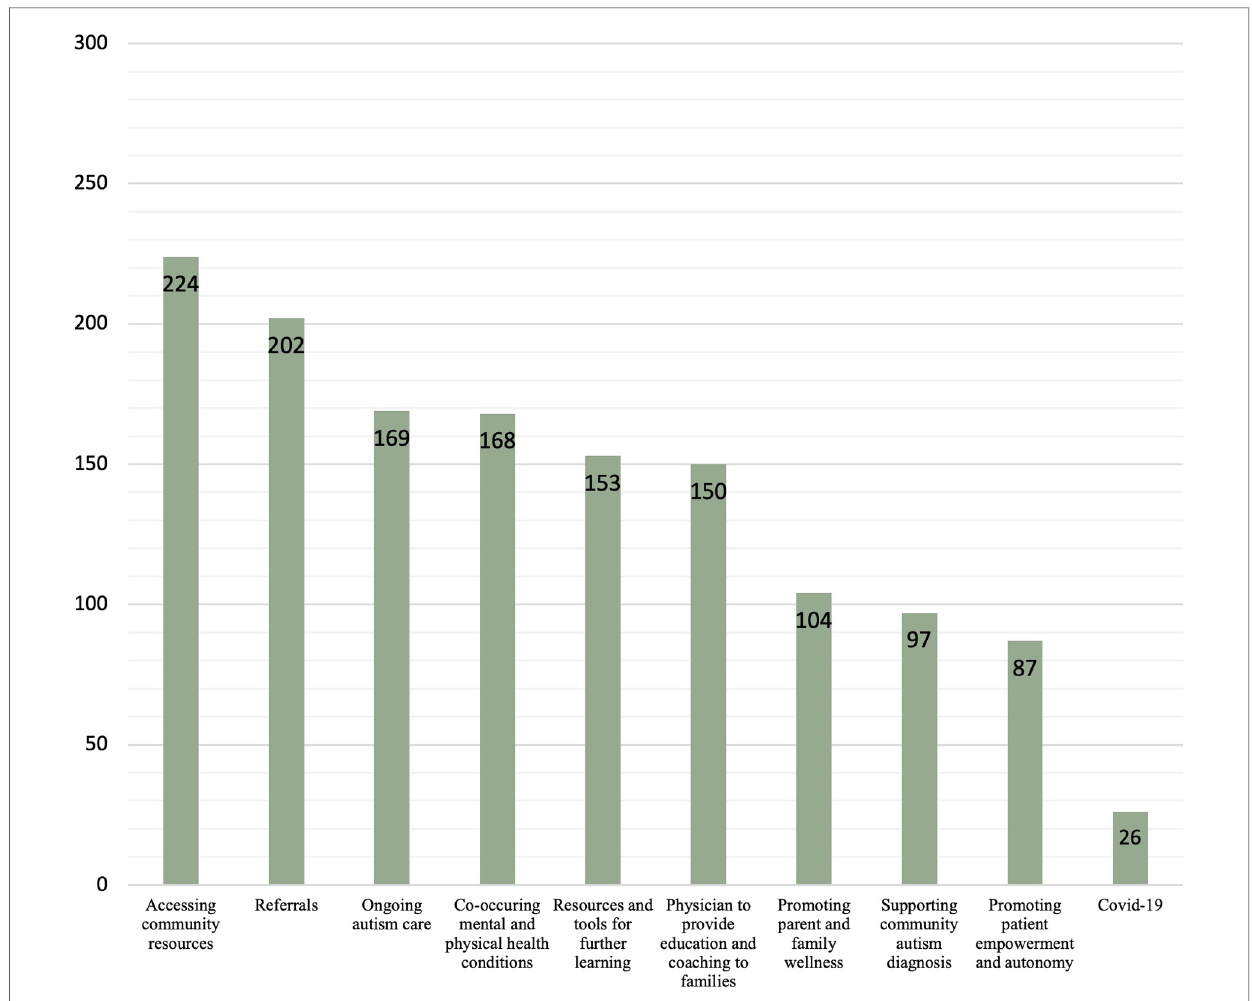
FIGURE 2 Frequency of categories in recommendations ( n ). Frequency of recommendation categories ( n ) in absolute value of total recommendations ( n =422). Categories include: (1) Accessing community resources ( n =224), (2) Referrals ( n =202), (3) Ongoing autism care ( n =169), (4) Co-occurring mental and physical health conditions ( n =168), (5) Resources and tools for further learning ( n =153), (6) Physician to provide education and coaching to families ( n =150), (7) Promoting parent and family wellness ( n =104), (8) Supporting community autism diagnosis ( n =97), (9) Promoting patient empowerment and autonomy ( n =87), and (10) COVID-19 ( n